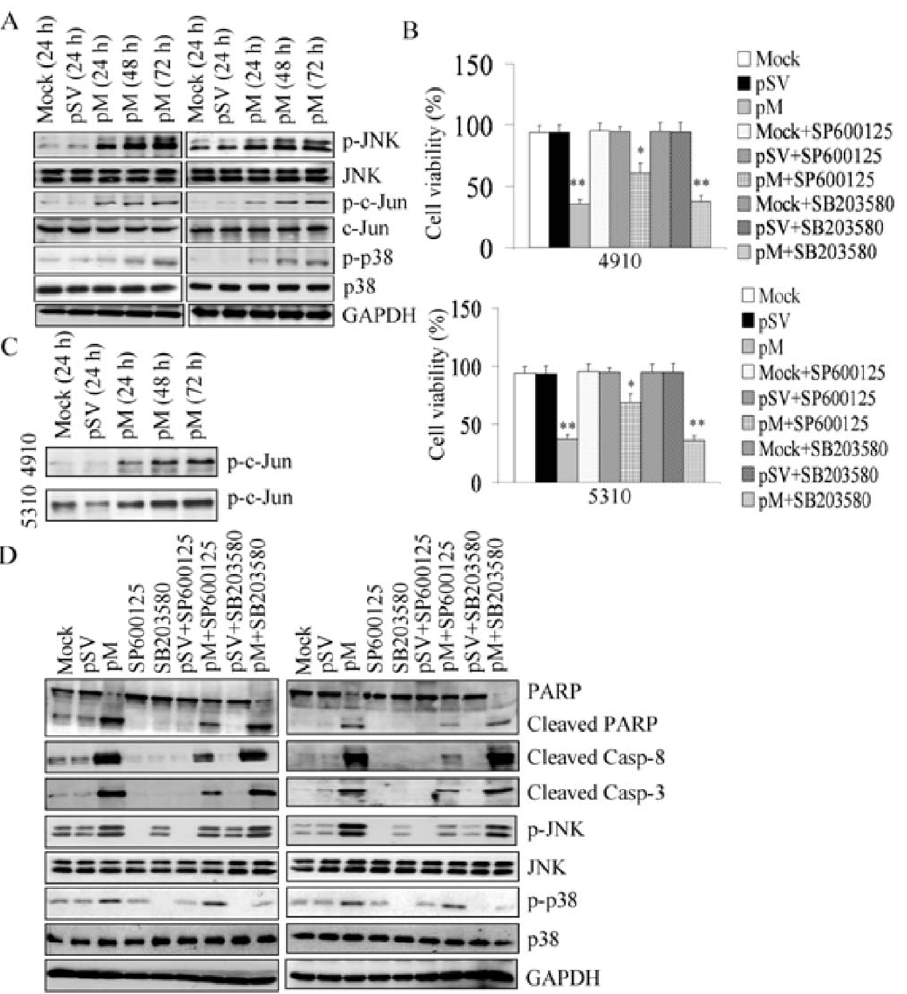
Figure 5. MMP-2 downregulation activated phosphorylation of MAP kinases and had a pro-apoptotic effect via activation of JNK. A. Whole cell lysates collected at different time points from mock, pSV- and pM-treated cells and were subjected to Western blotting. GAPDH was used as an internal control. Blots are representative of at least three independent experiments. B. The 4910 and 5310 cells were treated with mock, pSV and pM for 48 h and further treated with either SP600125 or SB203580 for another 24 h. At the end of 72 h cells were subjected to MTT cell viability assay. Data are presented as mean 6 SE and where significant difference among various treatment groups was represented by ‘‘*’’, at p , 0.05 and ‘‘**’’, at p , 0.01. C. Cells were collected at different time points (24 h, 48 h and 72 h) after pM transfection, and whole cell lysates were used to determine SAPK/JNK activity assay by quantitative immunoblotting using the non-radiolabeling method. Membranes were probed with phospho-c-jun (Ser 63). D. Individual treatments to 4910 and 5310 cells including mock, pSV and pM were carried out for 48 h followed by treatment with either SP600125 or SB203580 for another 24 h at the end of which cells were harvested. Whole cell lysates were subjected to Western blotting for cleavage of PARP, caspase-8 and caspase-3 and expression levels of phospho-JNK, JNK, phospho-p38 and p38. Representative blots from at least three independent experiments were shown.